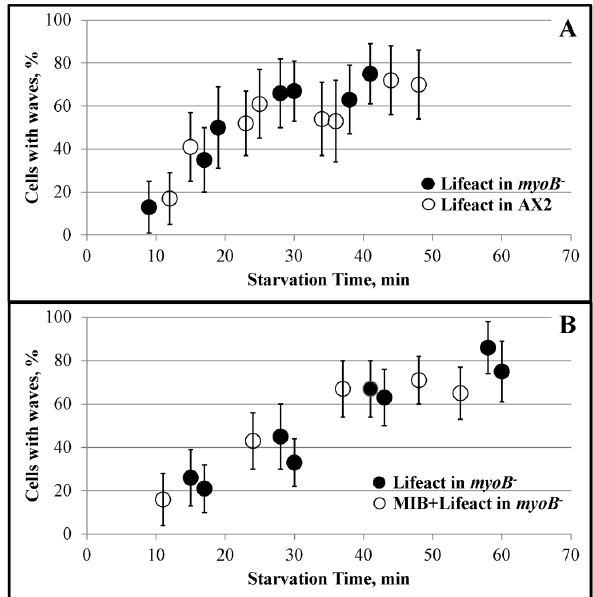
Figure 3. Time-course of the appearance of actin waves in cells starved for short times. The percentages of cells with waves are shown at the starvation times (min) indicated in the figure. Short movies (10 frames every 10 s) of randomly chosen fields were recorded. Cells in each field were scored for the presence of waves visualized with mRFP-lifeact. (A) Comparison of myoB 2 -cells (filled circles) and the parent WT-AX2 cells (open circles). Both cell lines were expressing mRFP-lifeact. (B) Comparison of myoB 2 -cells expressing either mRFP- lifeact alone (filled circles) or mRFP-lifeact and GFP-MIB (open circles). The two cell lines compared in A and B were grown and treated identically and recorded in the same experiment so the two cell lines within each panel can be directly compared with each other. The results are representative of two independent experiments. Error bars were calculated using the binomial probability confidence interval calculator developed by Daniel S. Soper (http://www.danielsoper.com/statcalc) and correspond to the 95% confidence